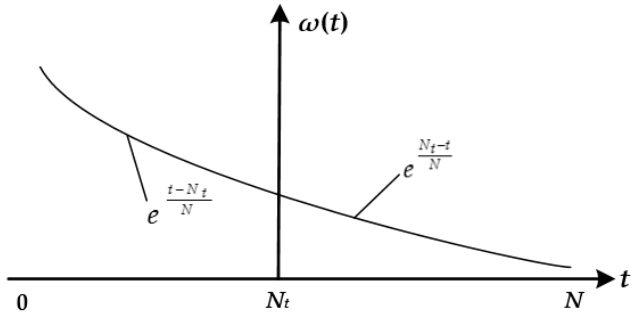
Figure 2. Distribution of inertia weight coefficient.